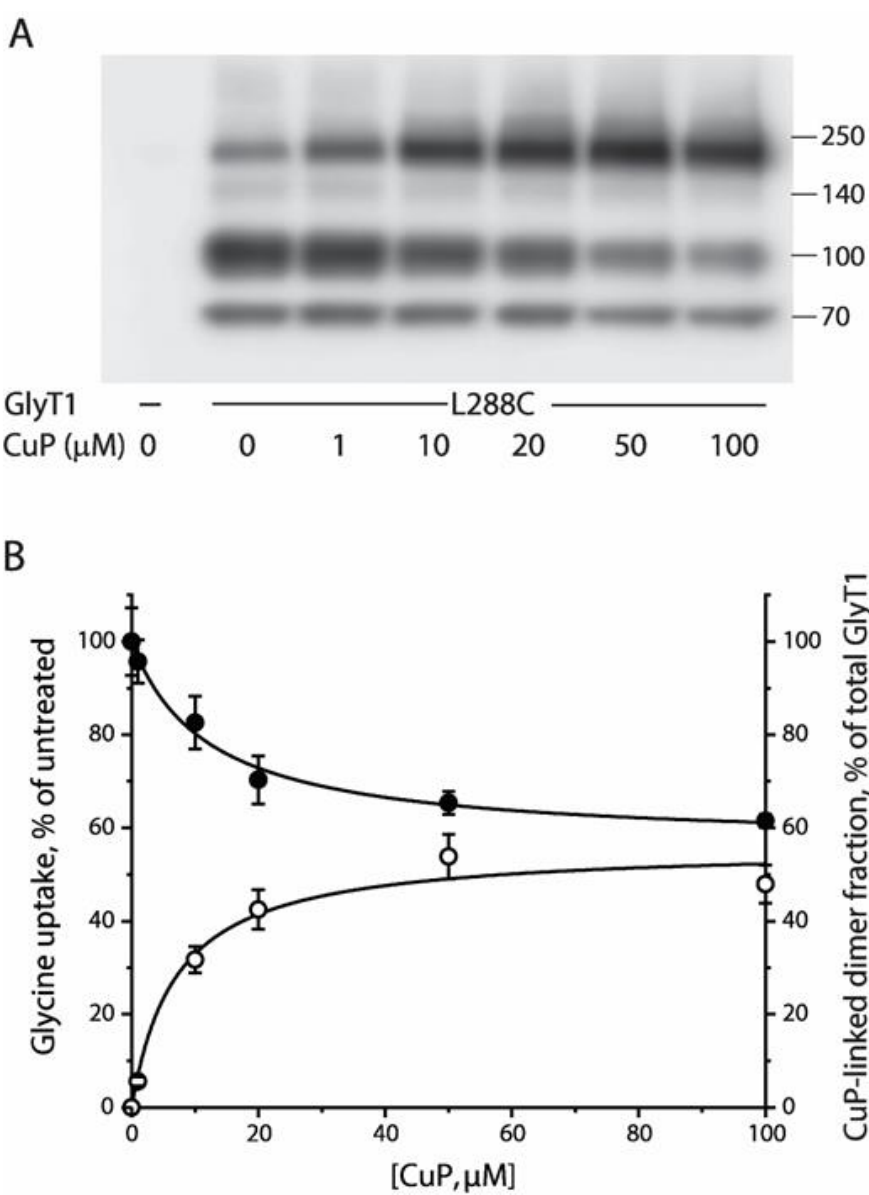
Figure 3. CuP concentration-dependent cross-linking and its influence on transport activity of GlyT1 L288C. ( A ) The representative immunoblot of CuP cross-linking of L288C. HEK-L288C cells were treated without or with CuP at indicated concentrations at 22 ◦ C for 15 min and then lysed. The FLAG-tagged L288C in cell lysates were detected by immunoblot analysis using anti-FLAG antibody. ( B ) Relationship between CuP-induced dimer fraction of GlyT1 ( ◦ ) or glycine uptake ( • ) and CuP concentrations. After HEK-L288C cells were treated with varying concentrations of CuP, [ 3 H]glycine uptake measurements and immunoblot analysis were parallelly performed. [ 3 H]Glycine uptake was expressed as a percentage of the value obtained without CuP treatment and CuP-induced dimer fraction was expressed as an increased dimer percentage caused by CuP cross-linking after subtracting a spontaneously occurring dimer percentage of total GlyT1 integrated density value. All results are presented as mean ± SEM averaged from three independent